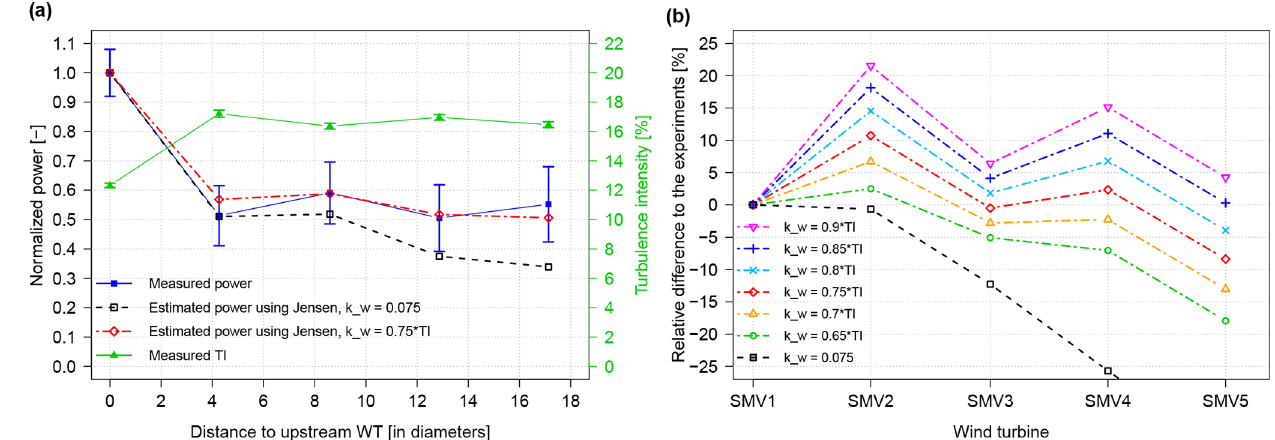
Figure 6. Comparison of the model performance at SMV wind farm. Variation of experimental and modelled normalized power and tur- bulence intensity (measured by the nacelle anemometer) along the row (a) and variation of the error of the model at each wind turbine for various values of wake decay constants k w (b) . Error bars indicates the 68% normalized confidence interval.